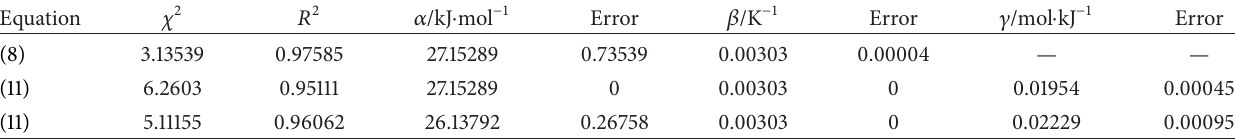
Table 3: Estimation results of proposed nonlinear regressions ((8) and (11)) between Arrhenius parameters.